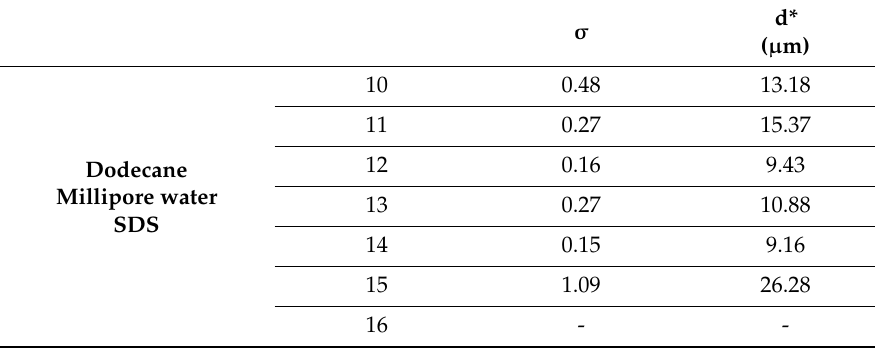
Table 6. Parameters of log-normal approximation of the experiments with Piston